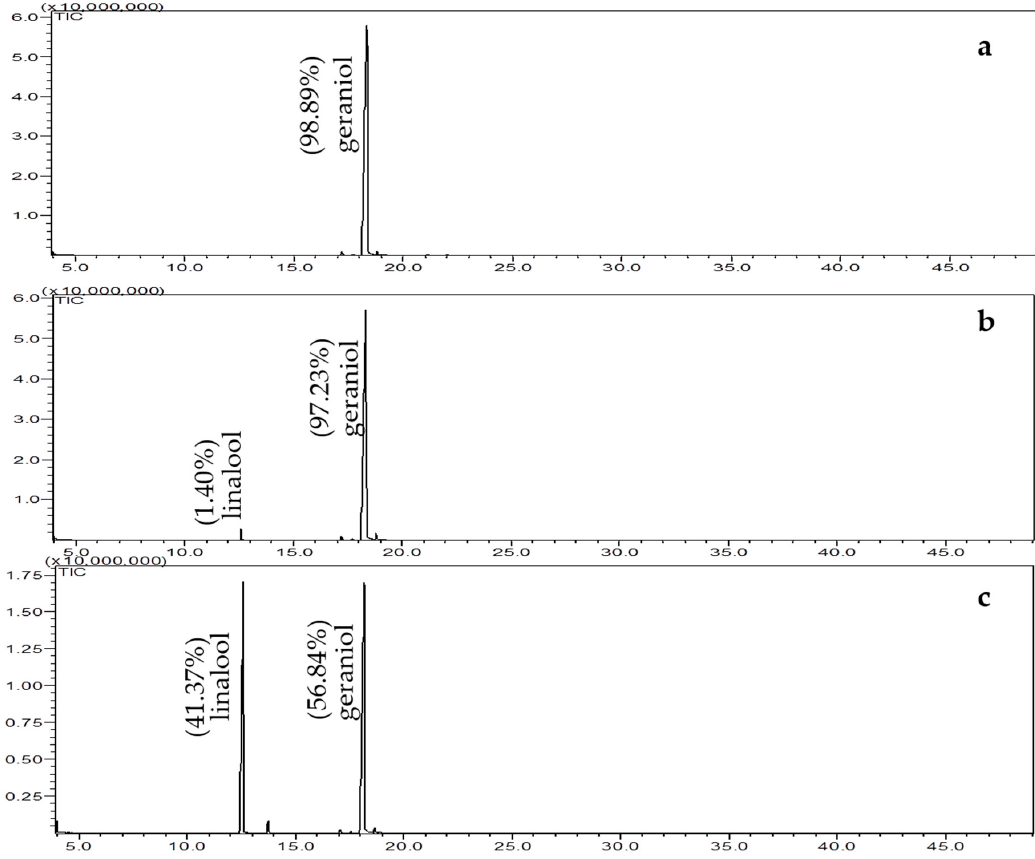
Figure 3. Chromatograms of the geraniol ( a ), hydrodistillation of geraniol ( b ) and solution of hydrodistillation of geraniol + linalool ( c ).